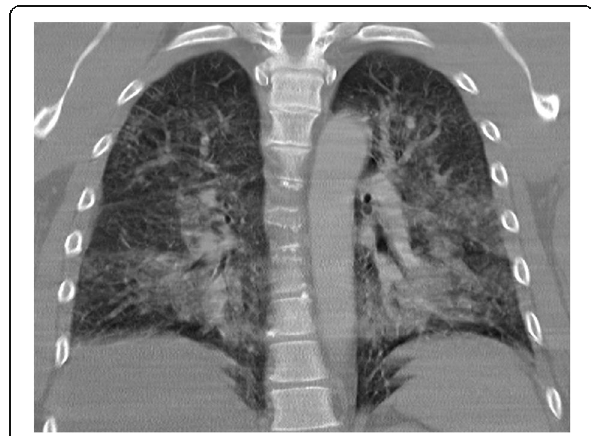
Fig. 3 Thoracal Scan, 03/15/2020, pleural infiltrates, not characteristic for SARS-CoV-2